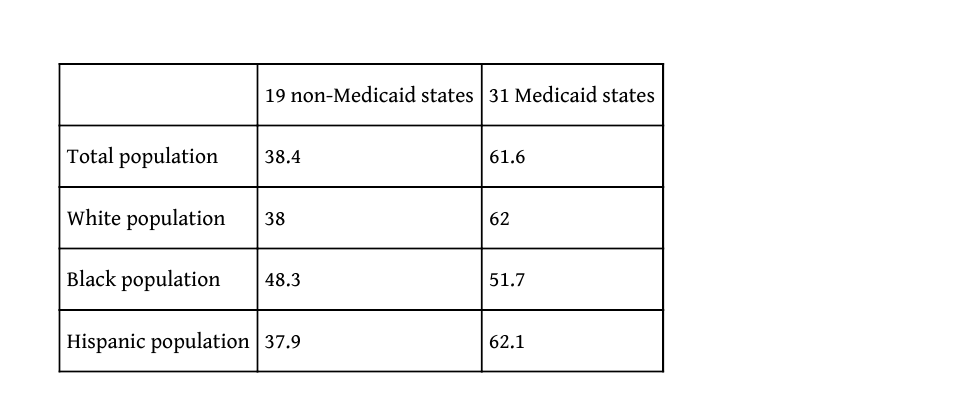
Figure 4. Population Concentration by Race and by State Medicaid Expansion Status, in percent, 2015 Data: Census.gov